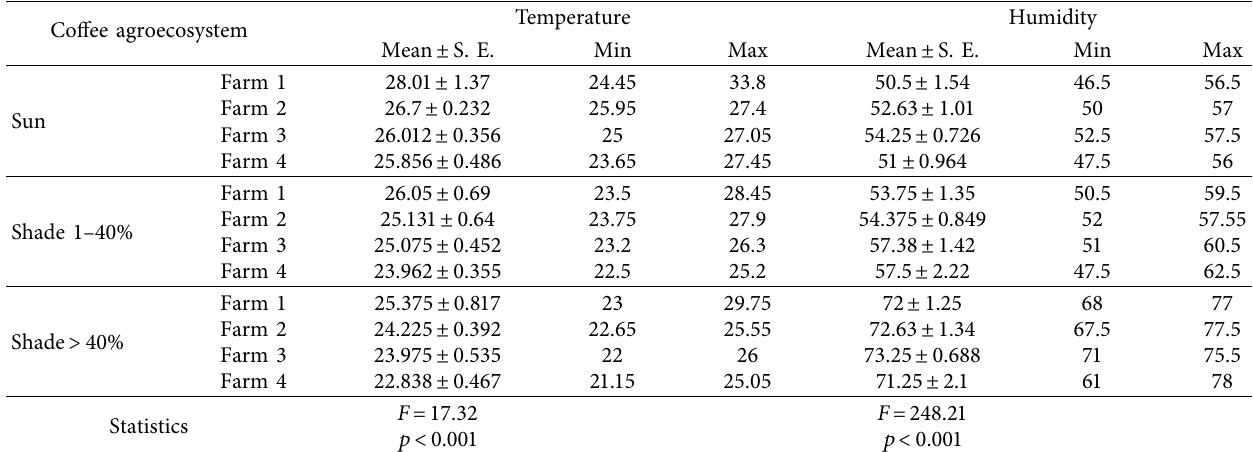
Table 4: Environmental variables measured in the study plots for the three cofee agroecosystems (sun, shade up to 40%, and shade > 40%). Mean ± S. E. are given for temperature and relative humidity. Statistics based on diferences between agroecosystems. Cofee